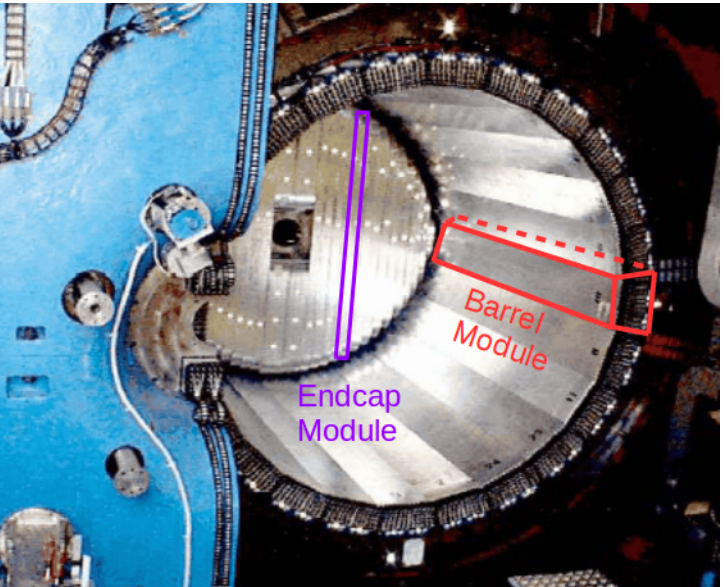
Figure 118. A view of the KLOE calorimeter. The far endcap is closed and ECAL modules can be seen as vertically oriented slabs. The barrel ecal modules are slabs that have a trapezoidal cross-section and that run along the barrel. The near yoke pole piece and end-cap calorimeter are